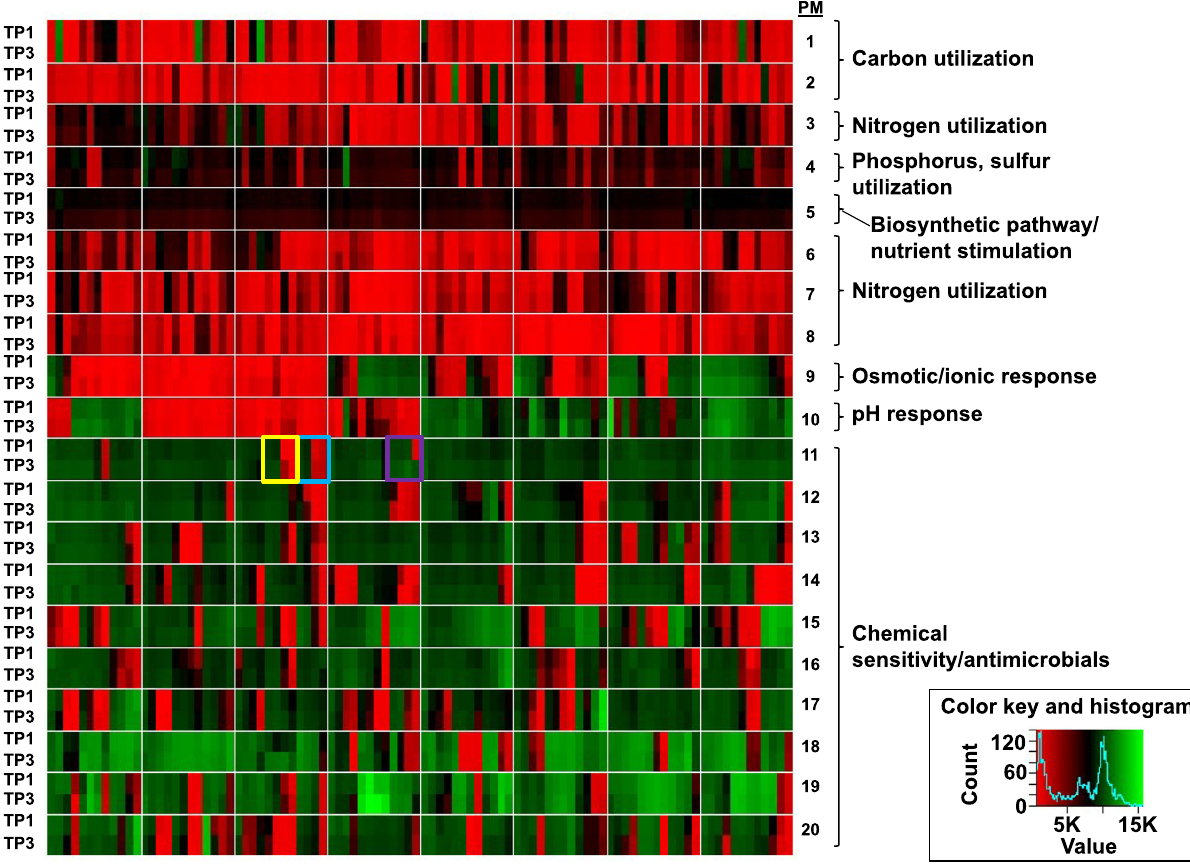
Fig. 3 Phenotypic pro fi ling of strains TP1 and TP3. Each row represents a bacterial isolate (TP1 or TP3) in one phenotype panel (PM01 – PM20), and each column represents a speci fi c condition (wells A01-H12) within each panel, as shown in Supplementary Data 1. Effects on bacterial metabolic activity are indicated by color, with red representing growth inhibition, black representing intermediate growth and green representing growth promotion. Yellow box: colistin. Light blue box: minocycline. Purple box: nafcillin. Results are calculated using the area under the curve for 48 h of growth and are presented as the average of three replicates per